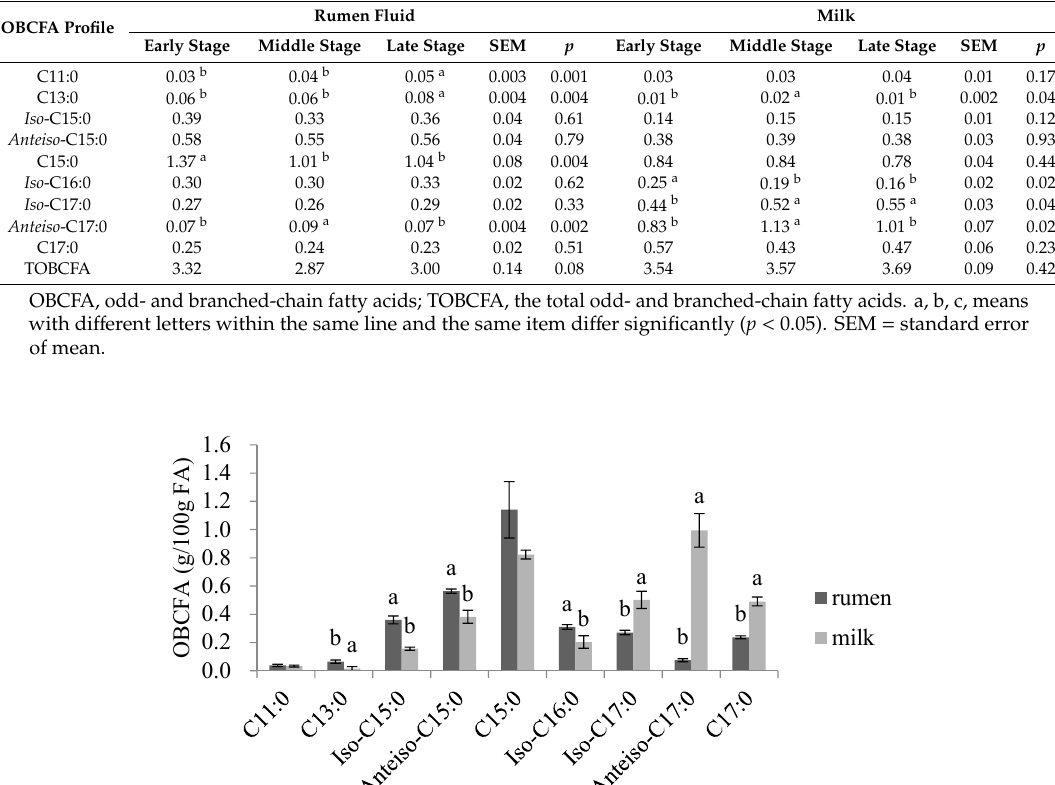
Table 3. Changes of di ff erent milk stages on OBCFA production in rumen fluid and milk (g / 100 g fatty acids). OBCFA Profile